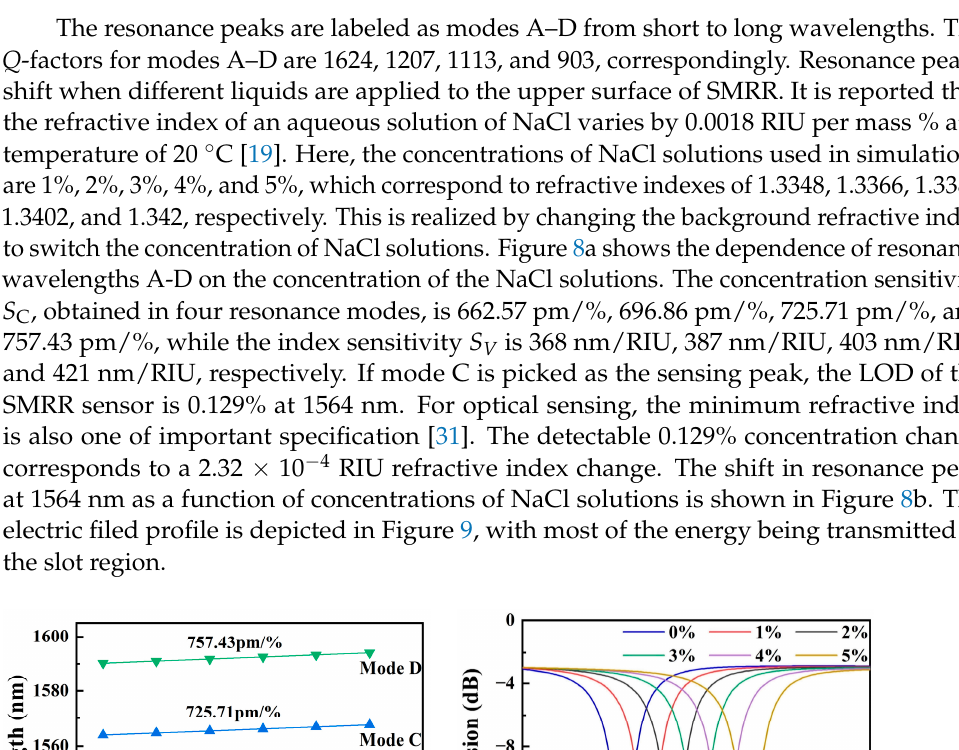
Figure 7. The transmission spectra of SMRR. ( a ) Bent and ( b ) straight waveguides are used as bus waveguides, respectively.